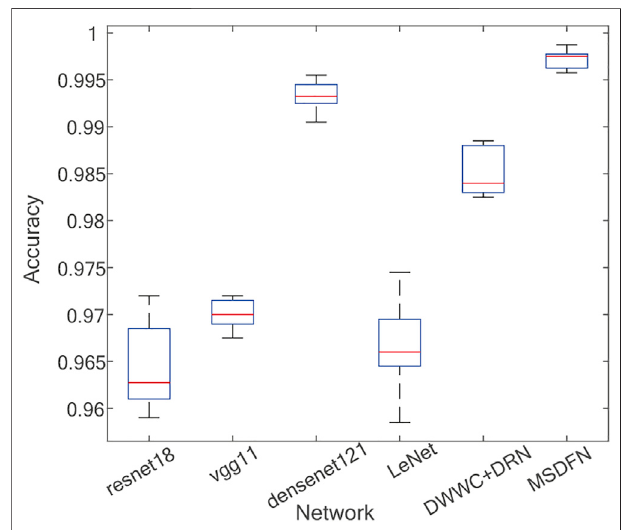
FIGURE 7 | Boxplots of the accuracies of different